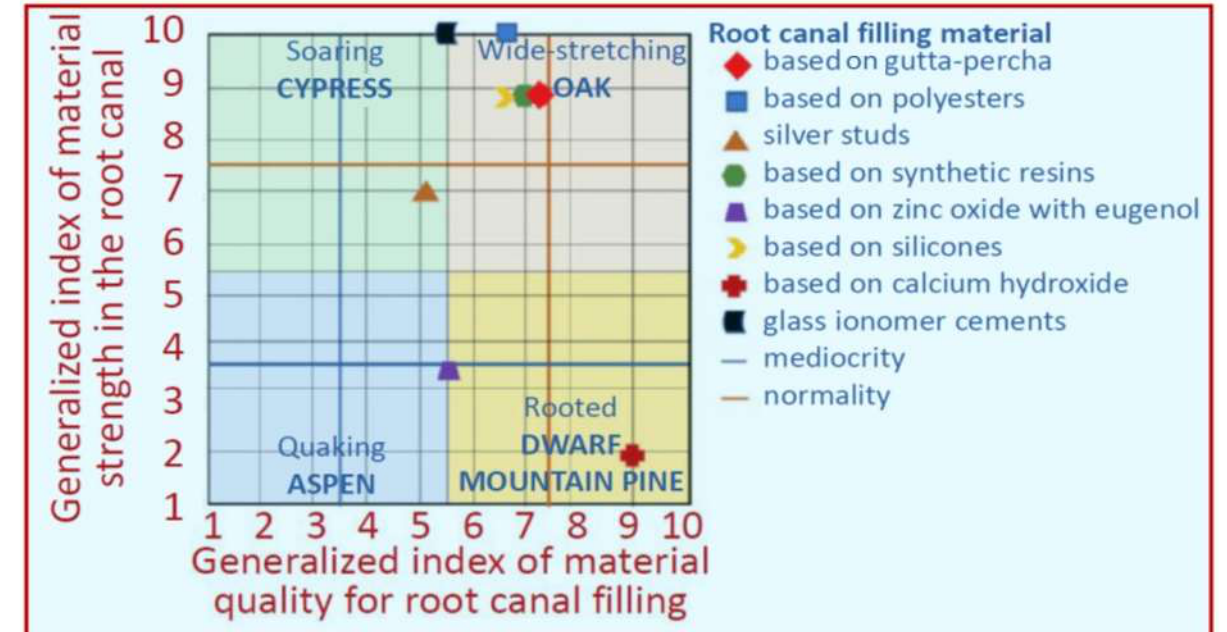
Figure 9. Contextual matrix of the attractiveness of materials used to fill root canals.